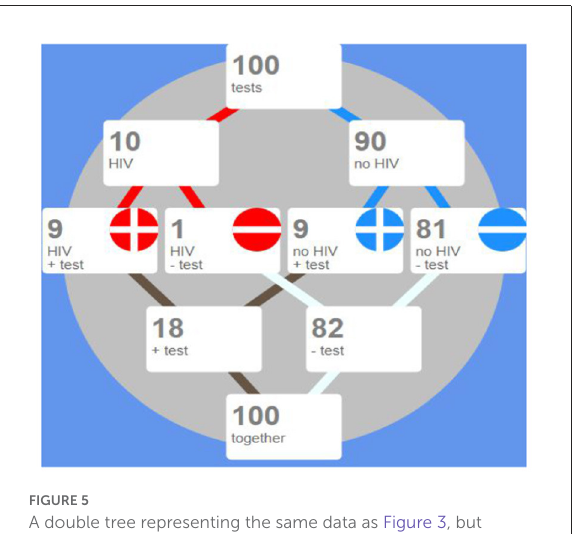
FIGURE5 A double tree representing the same data as Figure 3, but organized in a double tree.